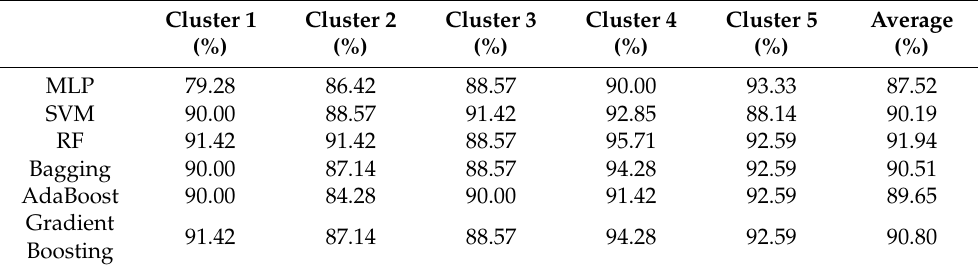
Table 6. Stratified K-fold Cross-Validation Accuracy Prediction For Six